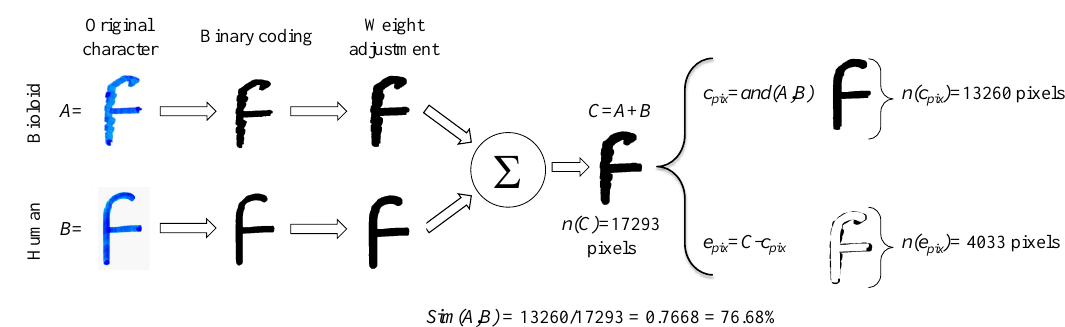
Figure 12. General steps of the quantitative assessment of the alphabet characters presented in Figure